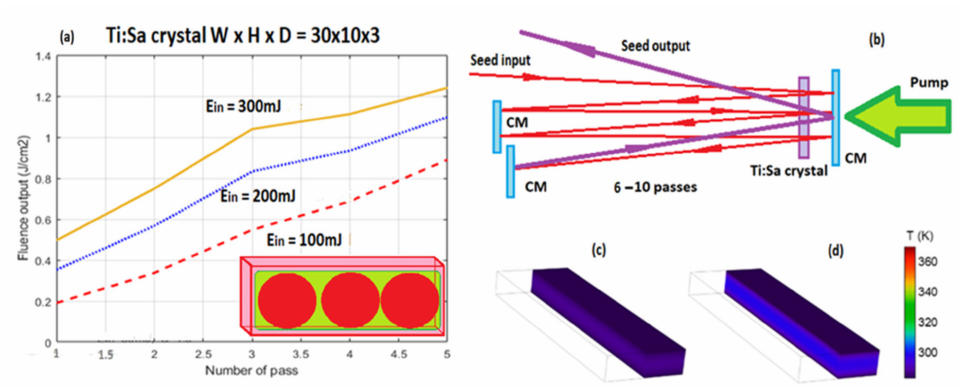
Figure 9. ( a )—Thin-slab Ti:Sa crystal (insert); dependence of the output pulse energy on the number of double seed passes for different input pulse energy. ( b )—Optical schema of the amplifier. ( c , d )—3D simulation of temperature distribution in the crystal for different pumping